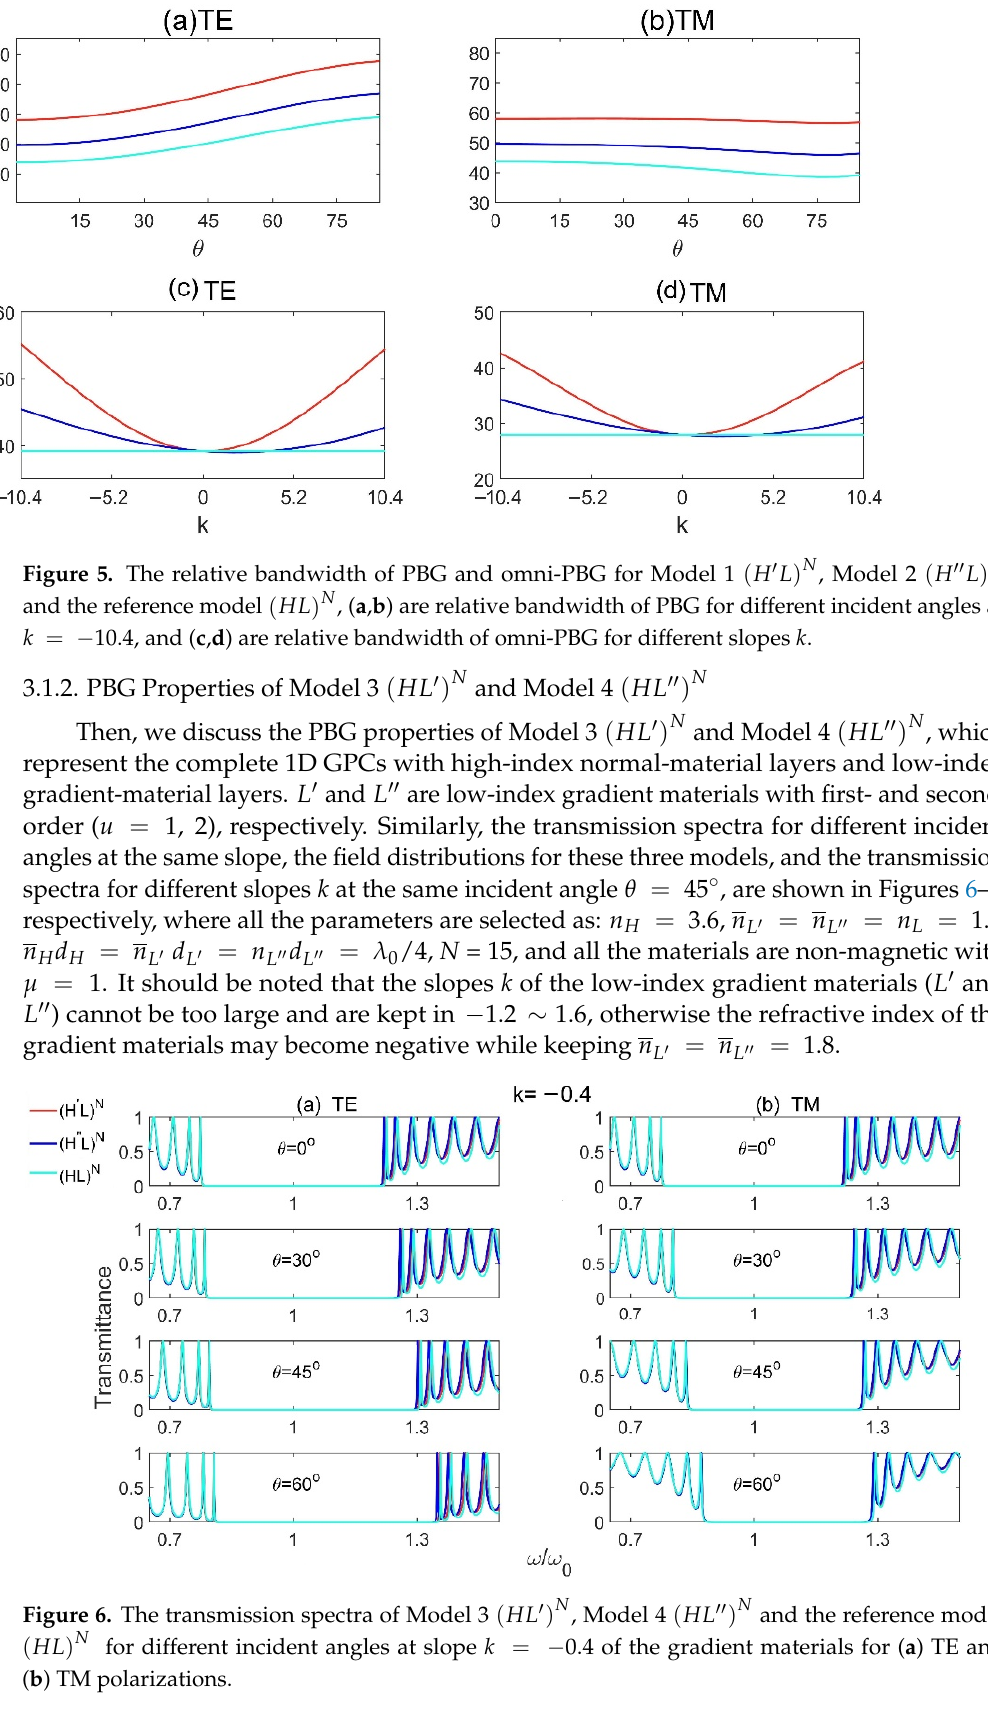
Figure 7. Field distributions for 𝜔 = 1.2𝜔 (cid:2868) and 𝑘 = −0.4 at incident angle 𝜃 = 0° for ( a ) Model 3 (𝐻𝐿 (cid:4593) ) (cid:3015) , ( b ) Model 4 (𝐻𝐿 (cid:4593)(cid:4593) ) (cid:3015) and ( c ) reference Model (𝐻𝐿) (cid:3015) , respectively.